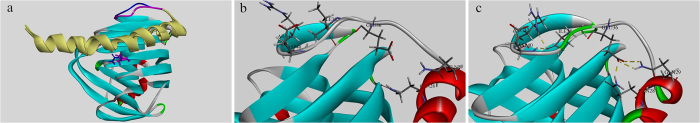
Homology modeling and structure comparison of wild type XynHB and XynHBN188A.(a) The predicted modeling structure of XynHB and XynHBN188A. Dark blue line is the structure of the wild type XynHB while purple is the mutant enzyme XynHBN188A. The mutation sites were shown by ball and line. The 34 amino acid sequence in the N-terminal which were from the vector was marked in yellow. (b) The N-terminus structure of wild type XynHB. (c) The N-terminus structure of mutant XynHBN188A.